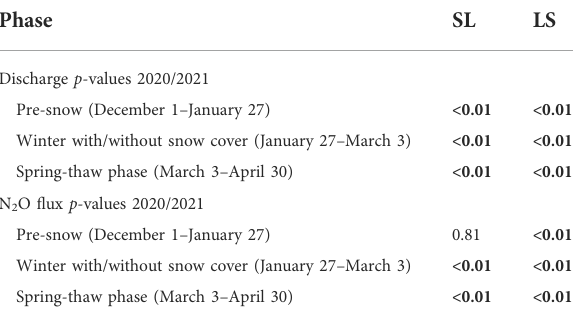
TABLE2 p -valuesofone-way t -testcomparingthemeanN 2 O fl uxand mean daily discharge between the snow removal treatments (WS and SR) within the soil types (SL and LS) and the three phases (Pre- Snow, Winter with/without snow cover, and Spring-thaw). Bold values indicated p ≤ 0.05.